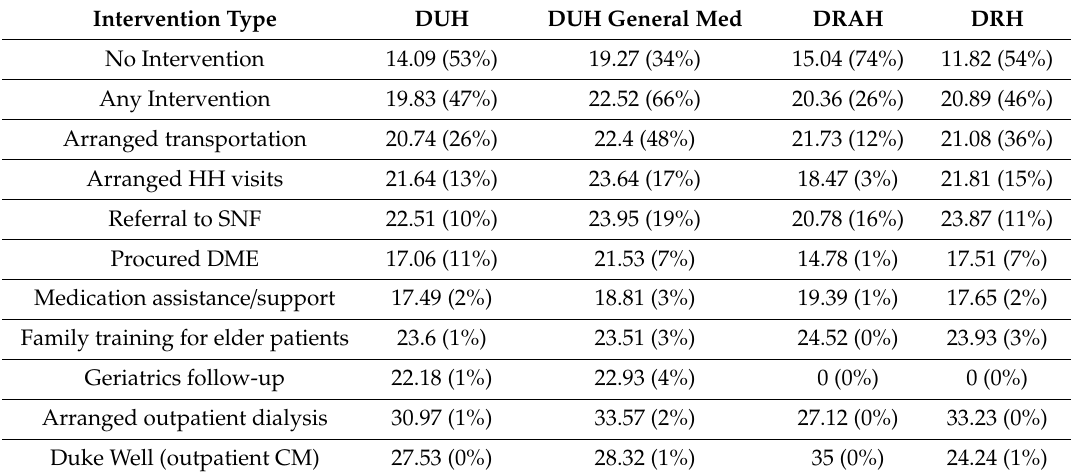
Table 3. Average readmission risk scores (percentage of encounters) for